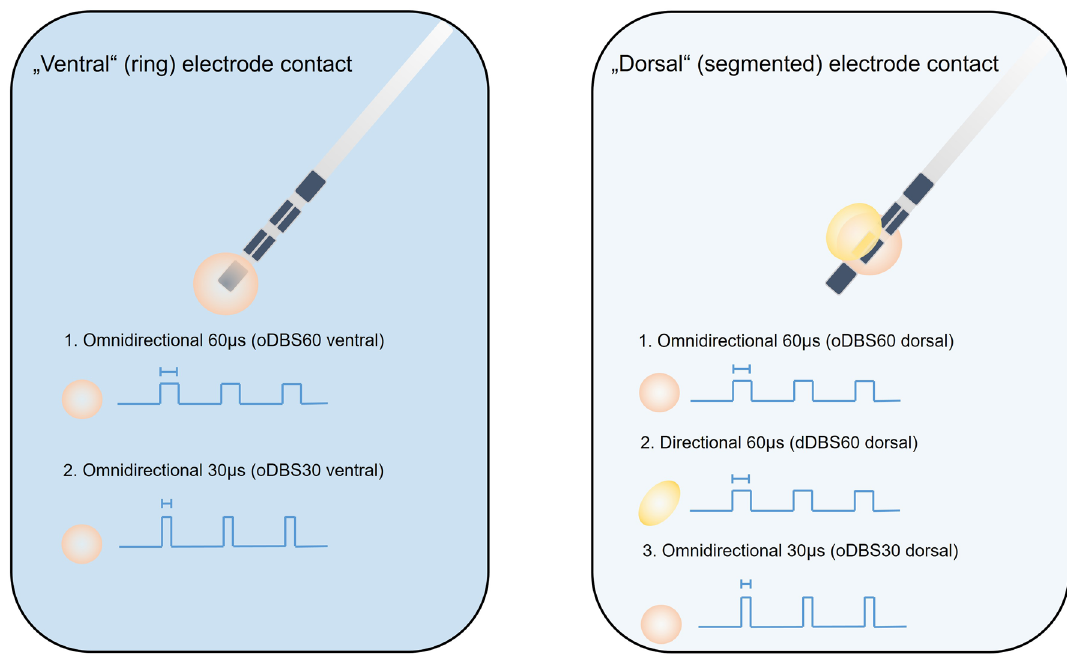
Figure 1. Study design. Parkinsonian (PD) and essential Tremor (ET) patients were studied in the following experimental conditions: (1) stimulation at the lowest, most ventral contact in an omnidirectional stimulation mode with a pulse width of 60 µs and 30 µs (left column), (2) Stimulation at the second lowest, dorsal, segmented contact with omnidirectional and directional stimulation at one single segment with a pulse width of 60 µs (right